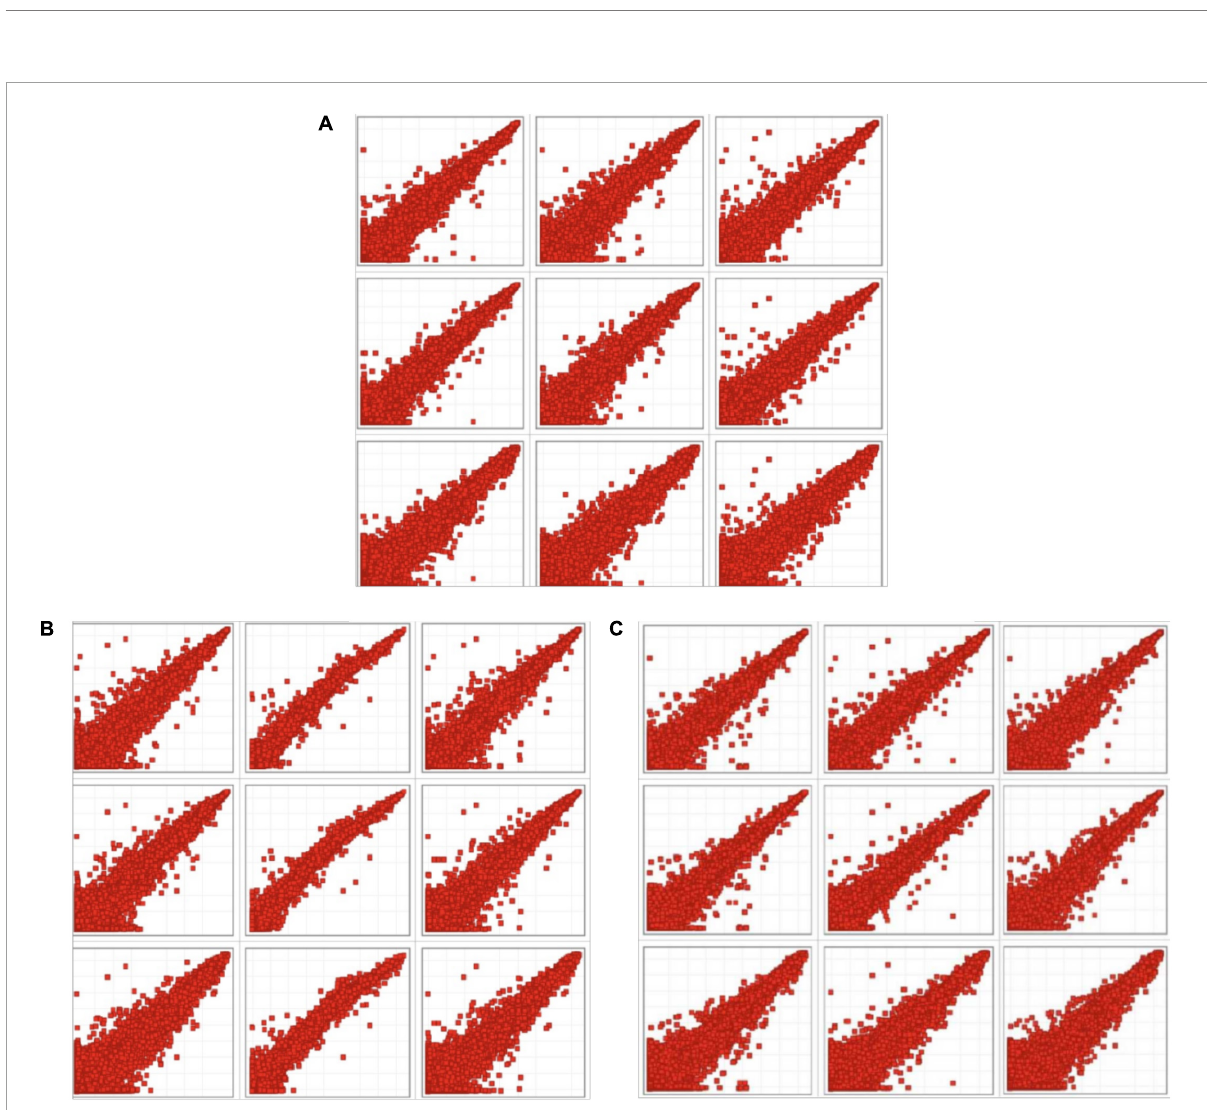
FIGURE1 Scatter plot of intervention groups compared with the model control group. (A) Scatter plot of fluorescence signal values in chrysanthemum flavonoids intervention group (CF) and model control group. (B) Scatter plot of fluorescence signal values in luteolin intervention group and model control group. (C) Scatter plot of fluorescence signal values in luteoloside intervention group and model control